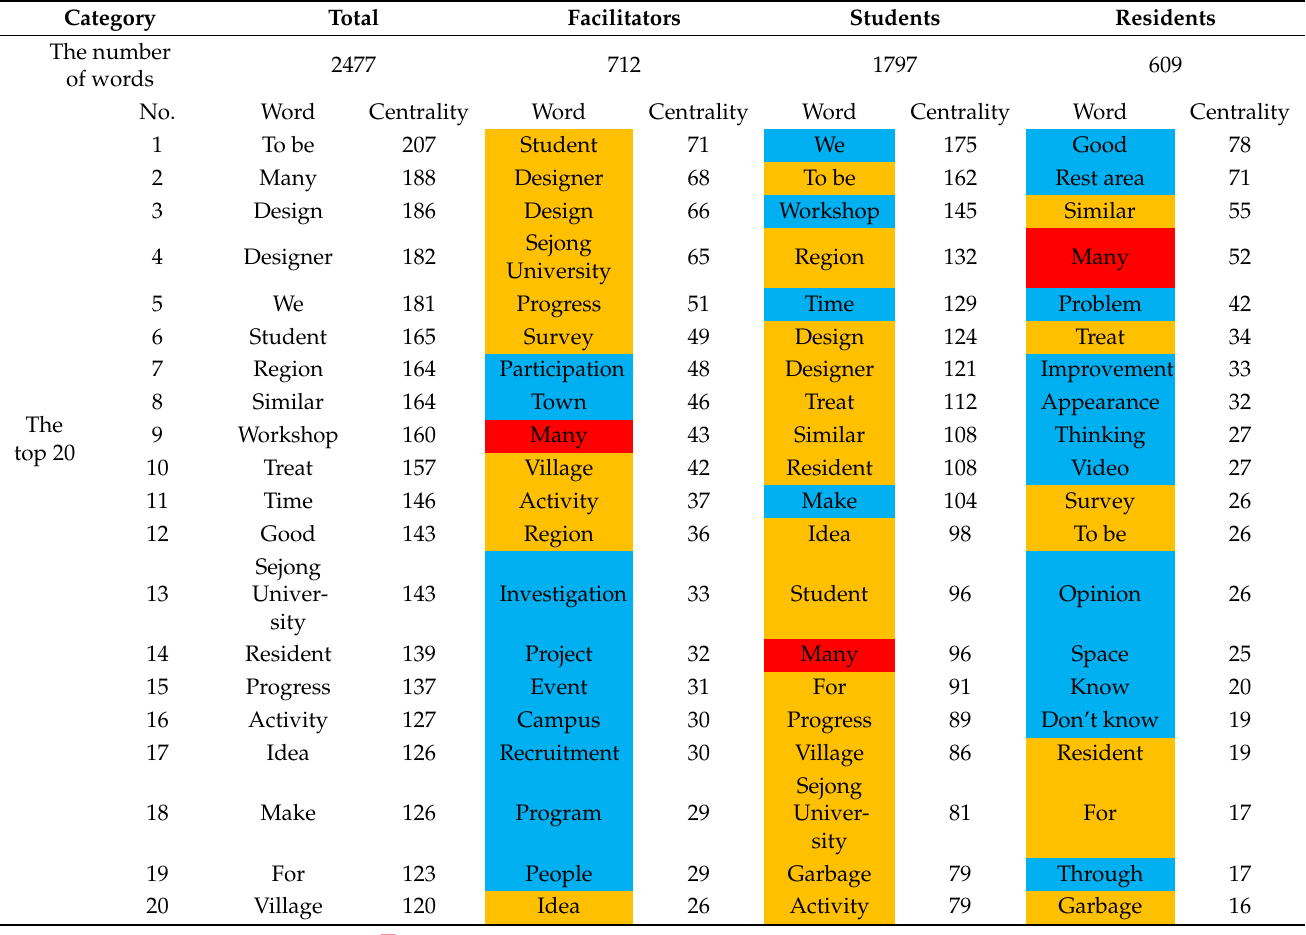
Table 8. The 3-g of centrality by the participant. Table 2. Frequency of words (nouns) mentioned by each participant. Table 2. Frequency of words (nouns) mentioned by each participant. Table 2. Frequency of words (nouns) mentioned by each